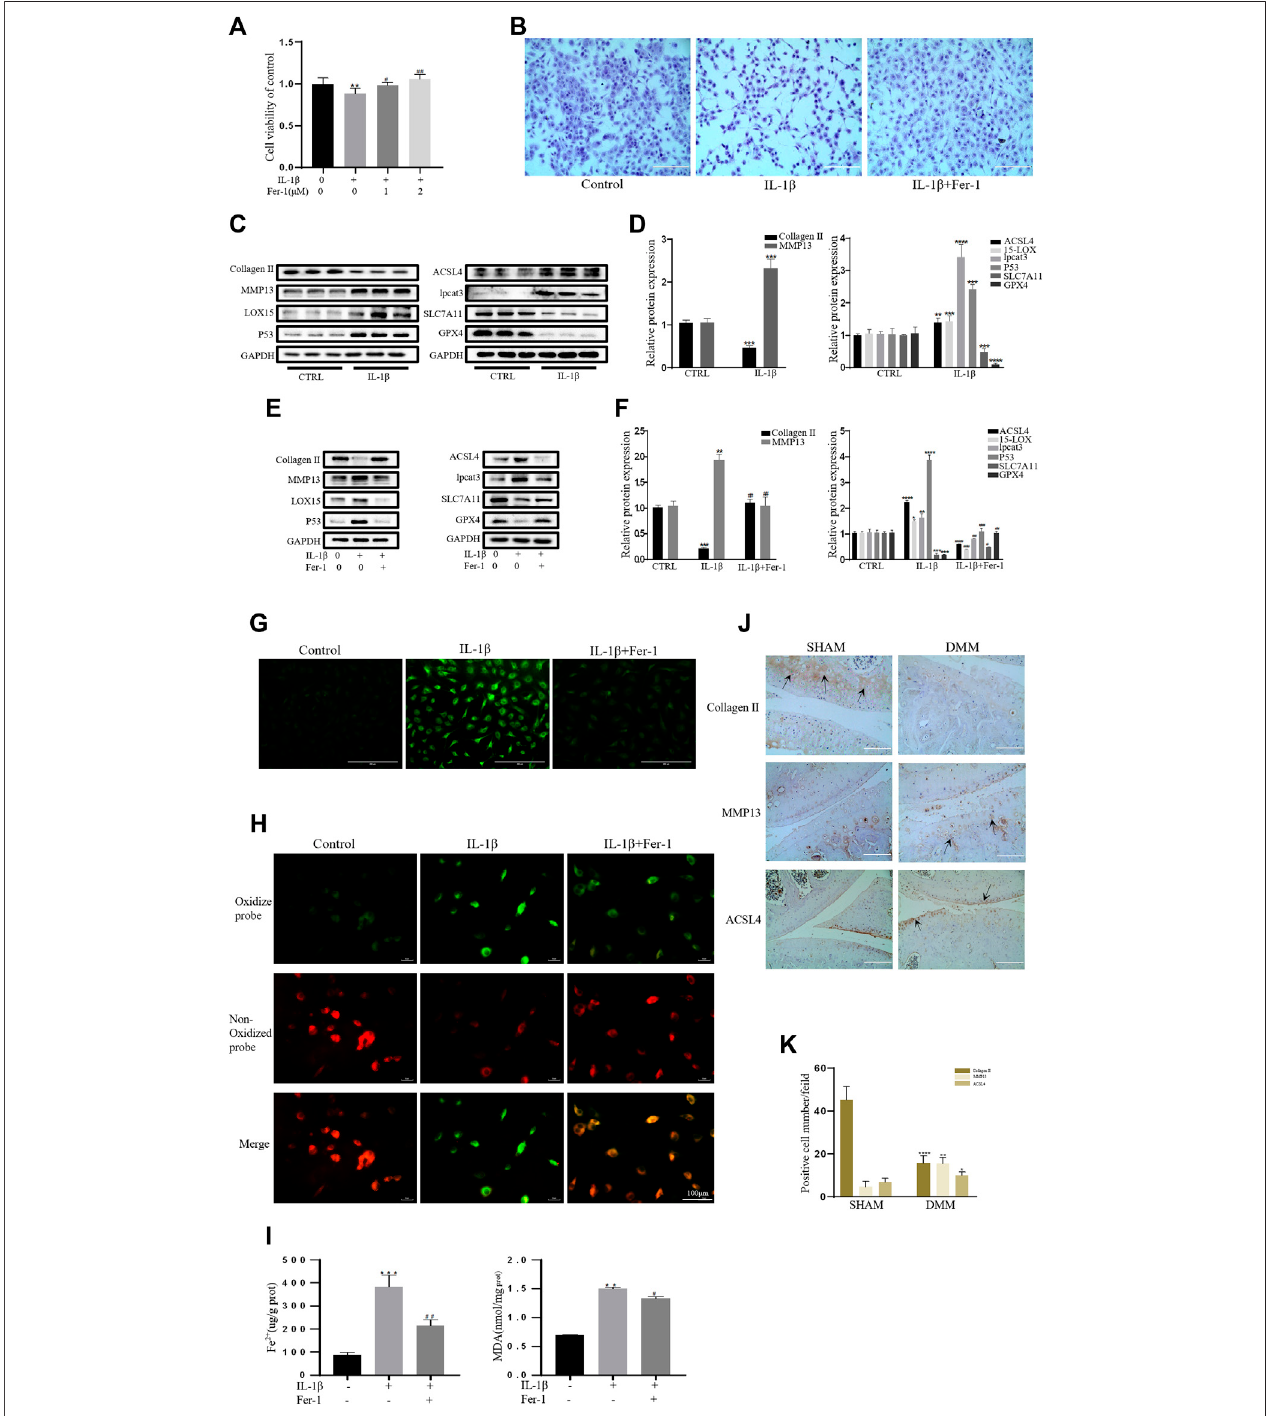
FIGURE2| IL-1 β inducedMDA,ROS,andlipid – ROSaccumulationandferroptosis-relatedproteinexpressionchangesinchondrocytes,whichcanberescuedby Ferrostatin-1. (A,B) Cell viability determined by CCK-8 assay and toluidine blue staining. (C,D) The protein expression levels of collagen Ⅱ , MMP13, ACSL4, LOX15, lpcat3, P53, and SLC7A11 GPX4 when treated by IL-1 β (10 ng/ml) were detected by Western blot, and band density ratios of collagen Ⅱ , MMP13, ACSL4, LOX15, lpcat3,P53,andSLC7A11GPX4toGAPDHintheWesternblotswerequanti fi edbydensitometry( n =3). (E,F) Theproteinexpressionlevelsofcollagen Ⅱ ,MMP13, ACSL4,LOX15,lpcat3,P53,andSLC7A11GPX4whentreatedbyIL-1 β (10 ng/ml)withfer-1(1 μ M)orequalvolumeofDMSOweredetectedbyWesternblot,andband density ratios of collagen Ⅱ , MMP13, ACSL4, LOX15, lpcat3, P53, and SLC7A11 GPX4 to GAPDH in the Western blots were quanti fi ed by densitometry ( n = 3). (G) Intracellular ROS level detected by DCFH-DA fl uorescent probe (scale bar: 200 µm). (H) Intracellular lipid-ROS level detected by C11 BODIPY fl uorescent probe (scale